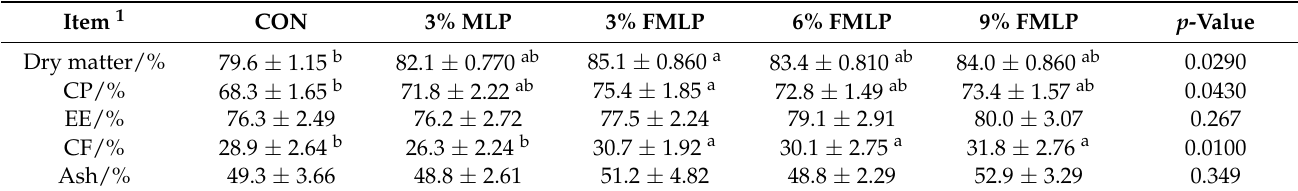
Table 4. Effects of FMLP on apparent nutrient digestibility of broilers.